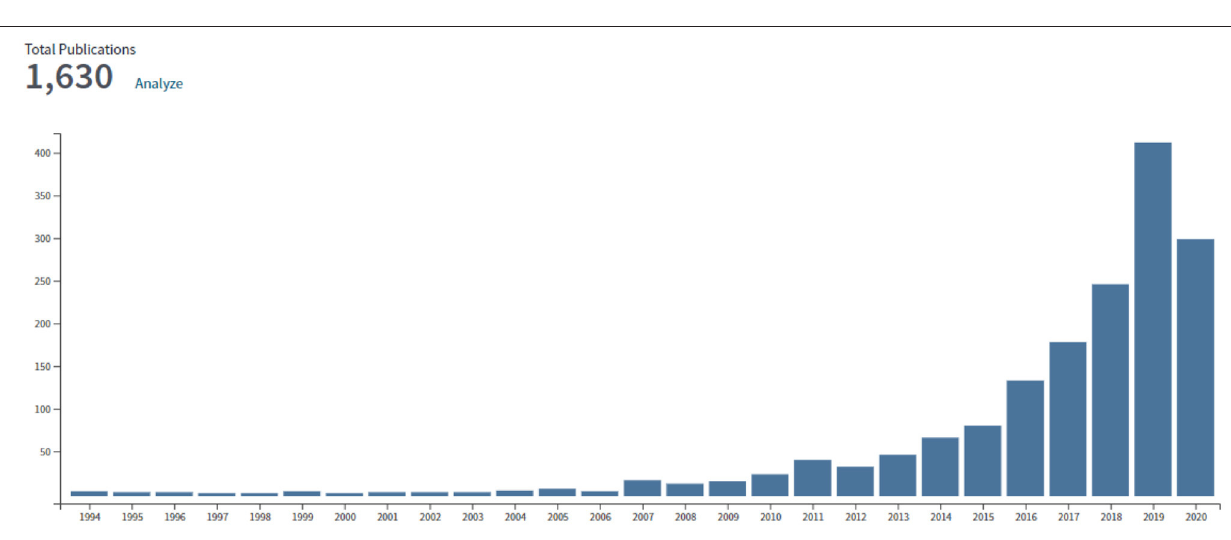
KAUST ( n = 61), King Fahd University of Petroleum ( n =